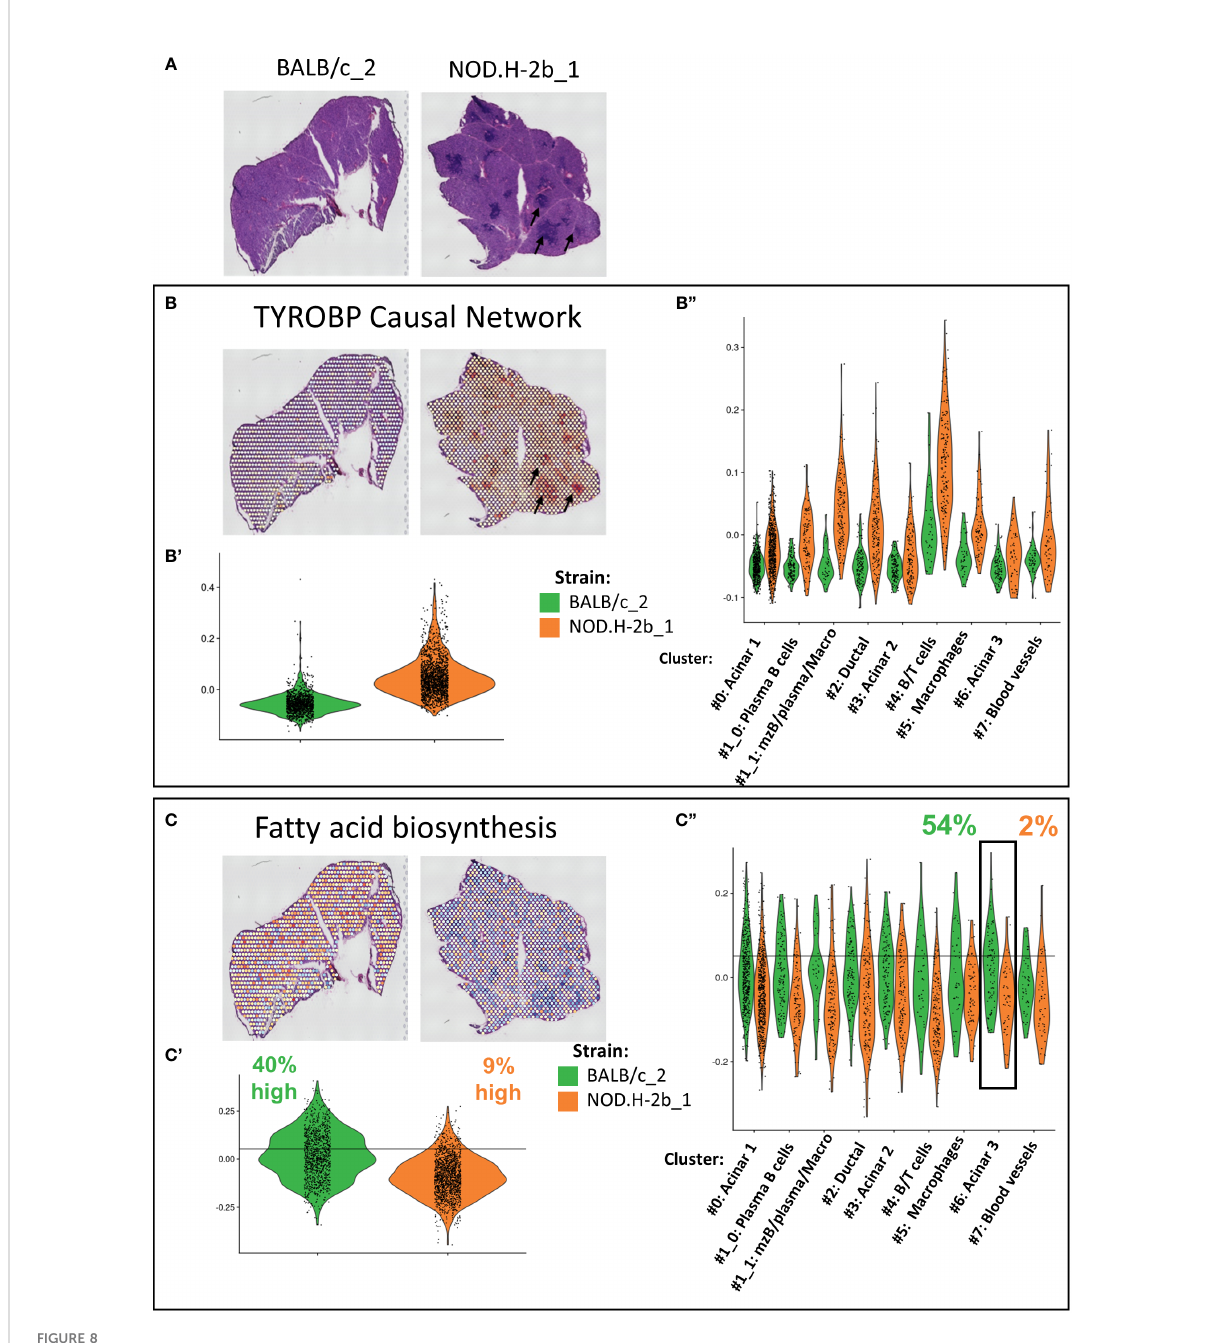
FIGURE 8 Validation and localization of altered pathways identi fi ed by meta-analysis of bulk RNAseq in Visium. (A) Scan of cryosections samples sequenced with visium are presented for reference. Genes involved in altered pathways identi fi ed by the meta-analysis in Figure 3C have been used to established a signature of genes. Score of (B) TYROBP Causal Network (upregulated in NOD bulk RNAseq) with Violin plot comparing score between BALB/c and NOD of the whole section (B ’ ) and per cluster (B ” ) . (C) Fatty acid biosynthesis (downregulated) in NOD bulk RNAseq. signature was calculated for each spot and plot on visium samples with Violin plot comparing score between BALB/c and NOD of the whole section (C ’ ) and per cluster (C ’’ )